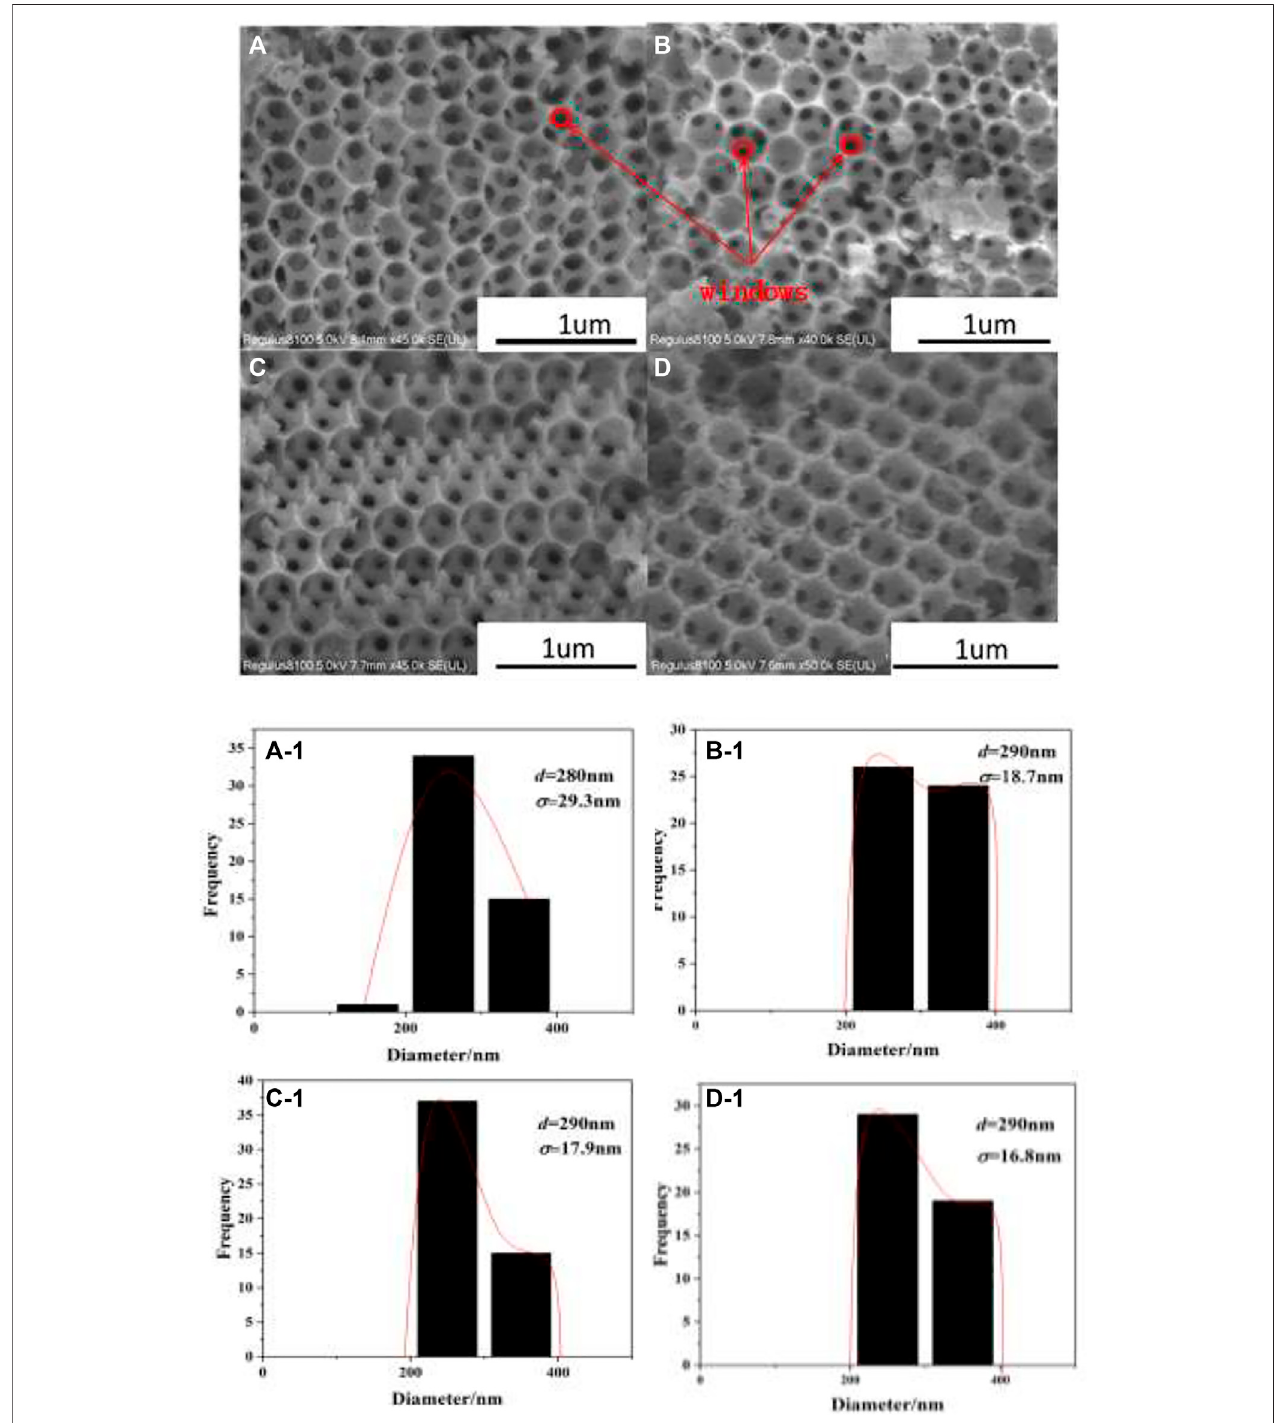
FIGURE 3 | SEM images of 3DOM catalysts and histograms of macropores ’ diameters. (A) W 1 CeO δ /ZrTiO 4 ; (B) W 1 MnO δ /ZrTiO 4 ; (C) W 1 CeMnO δ /ZrTiO 4 ; (D)